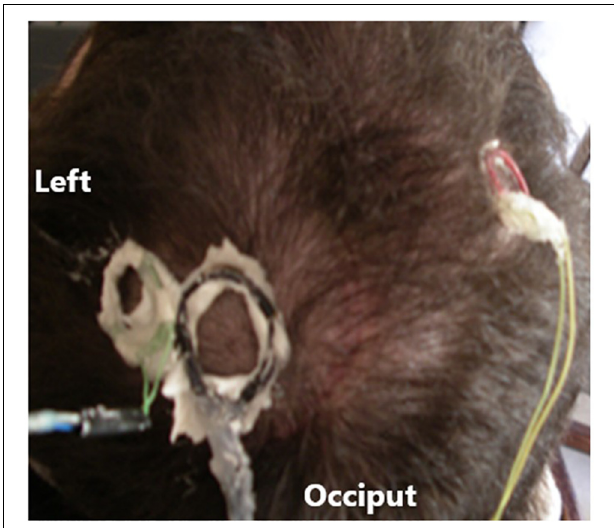
FIGURE 2 | Head of subject 5 with attached